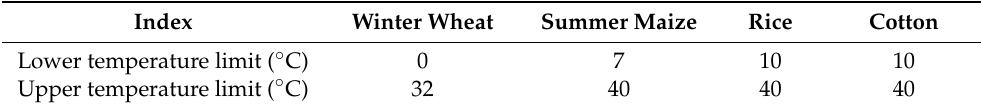
Table 9. Biological Upper and Lower Temperature Limits for the Four Crops. Index Winter Wheat Summer Maize Rice Cotton Lower temperature limit ( ◦ C) 0 7 10 10 Upper temperature limit ( ◦ C) 32 40 40